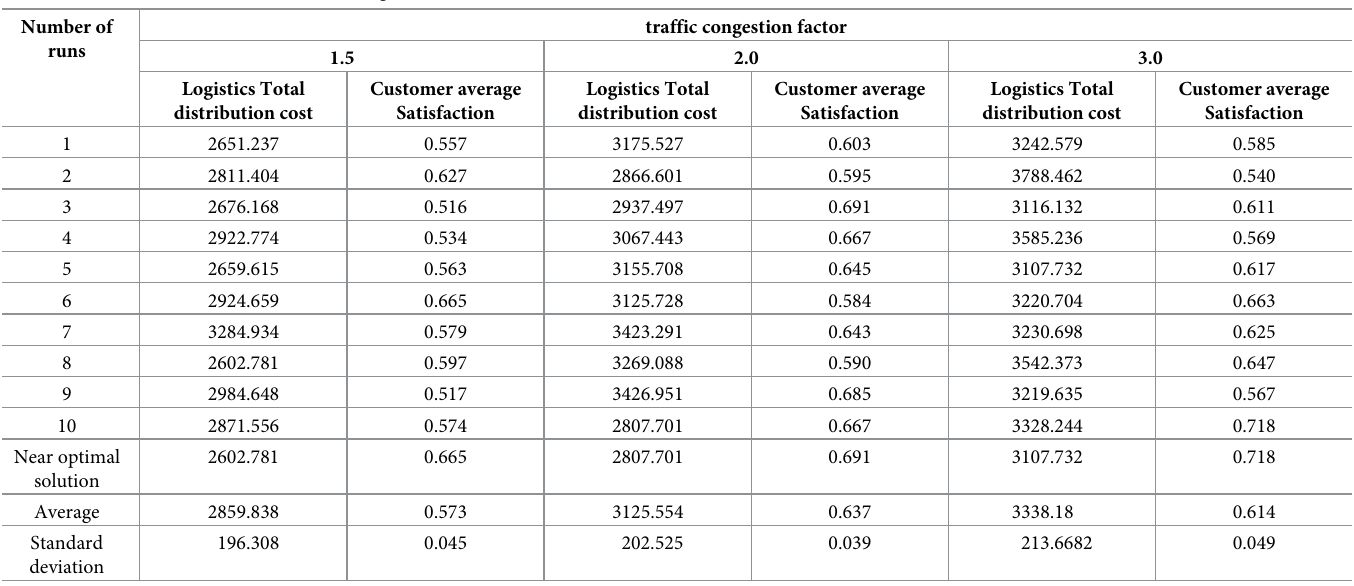
Table 11. Solution results based on traffic congestion